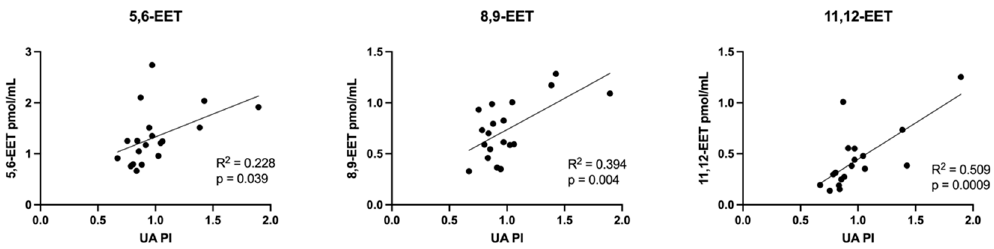
satility index (UA PI): lysophosphatidylcholines. Scatterplots demonstrate correlation relationships